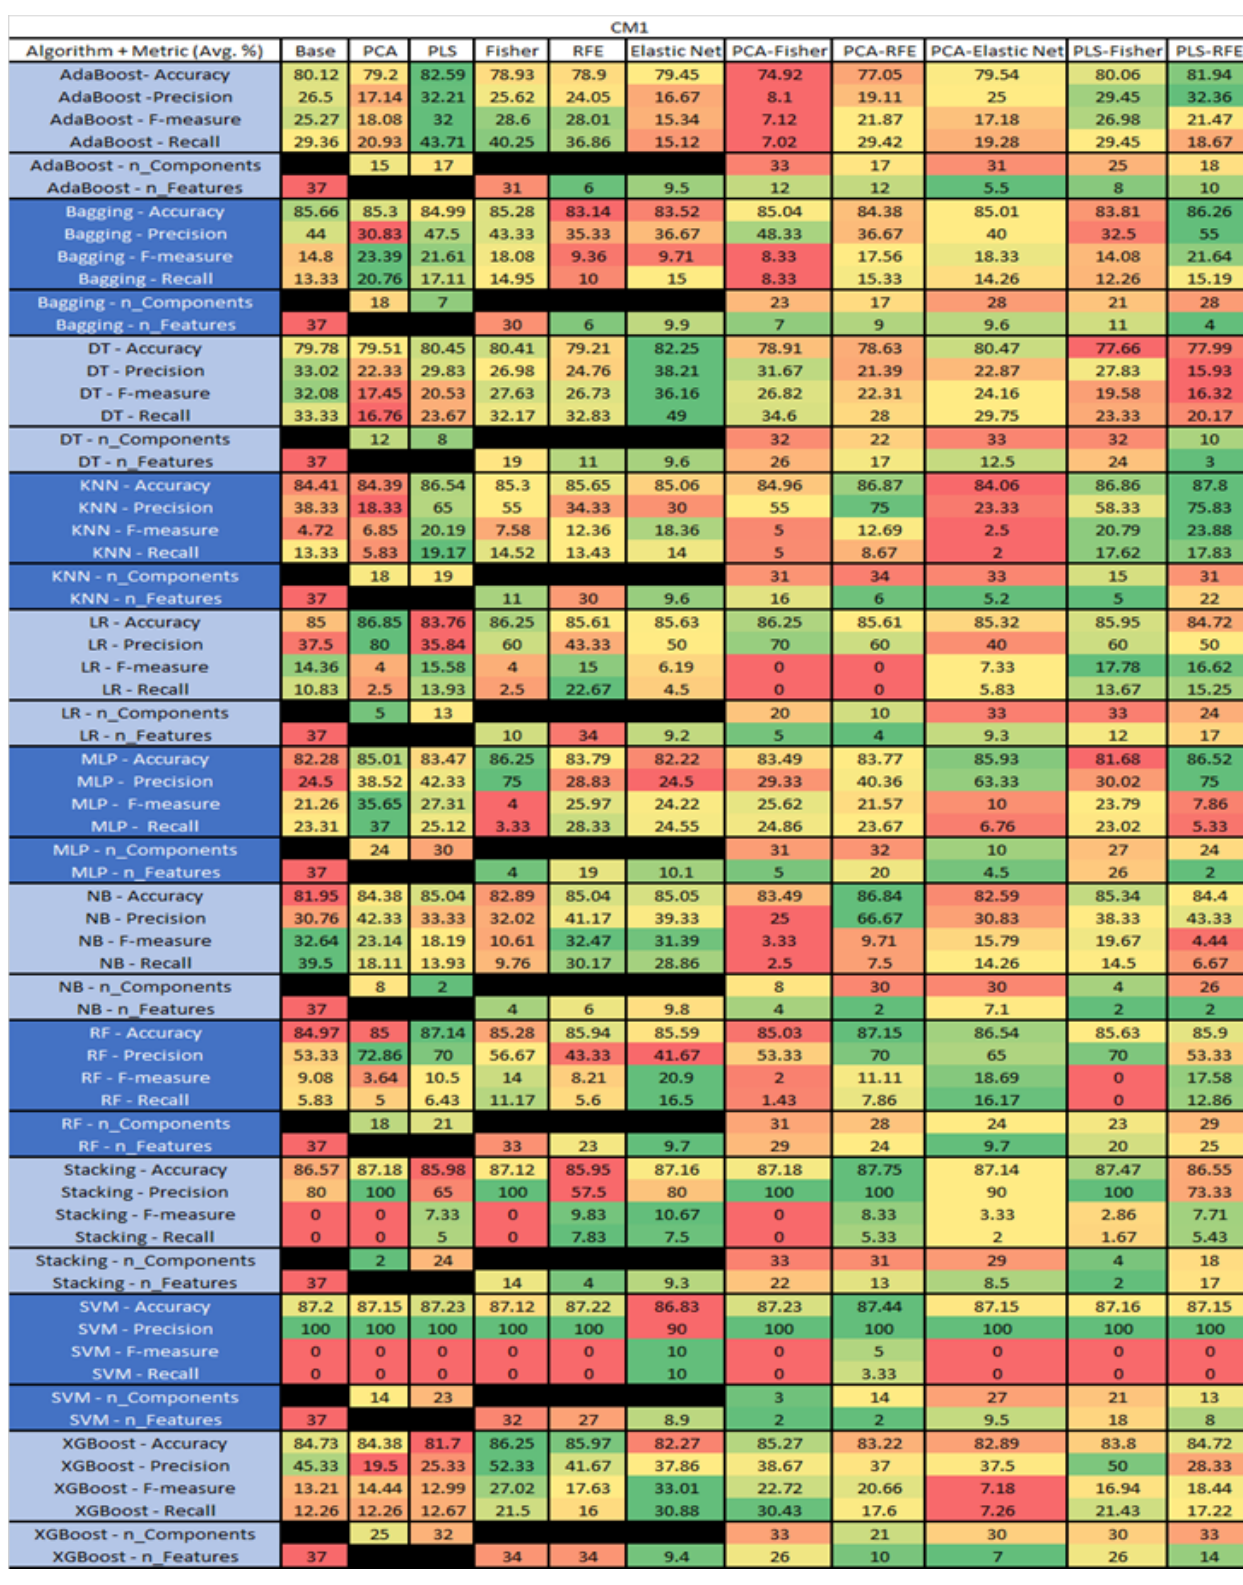
Figure 18. CM1 NASA MDP Results Data